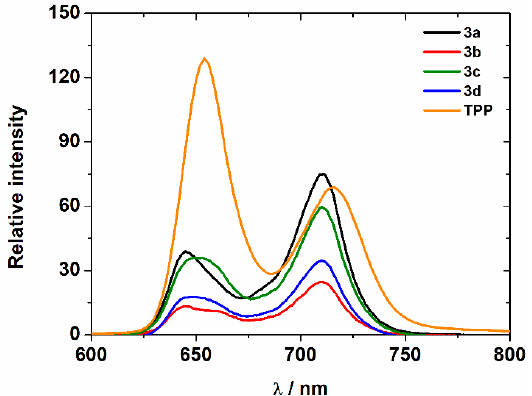
Figure 2. Emission spectra of porphyrin derivatives (excitation at λ exc = 418 nm) in argon saturated CHCl 3 solutions. Table 2. Absorption and emission data of porphyrin derivatives 3a – d .